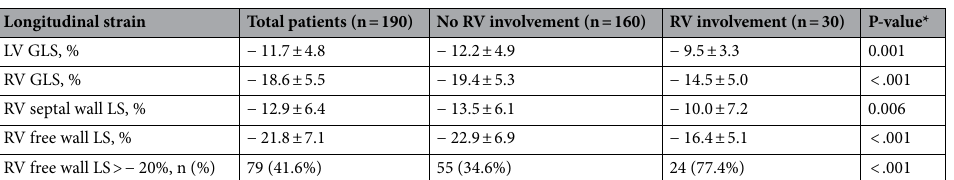
Table 3. Comparison of the left and right ventricular longitudinal strain values between patients with RV involvement and those without RV involvement (n = 190). RV right ventricle, LV left ventricle, LS longitudinal strain, GLS global LS. *P value between patients with RV involvement and patients without RV involvement.